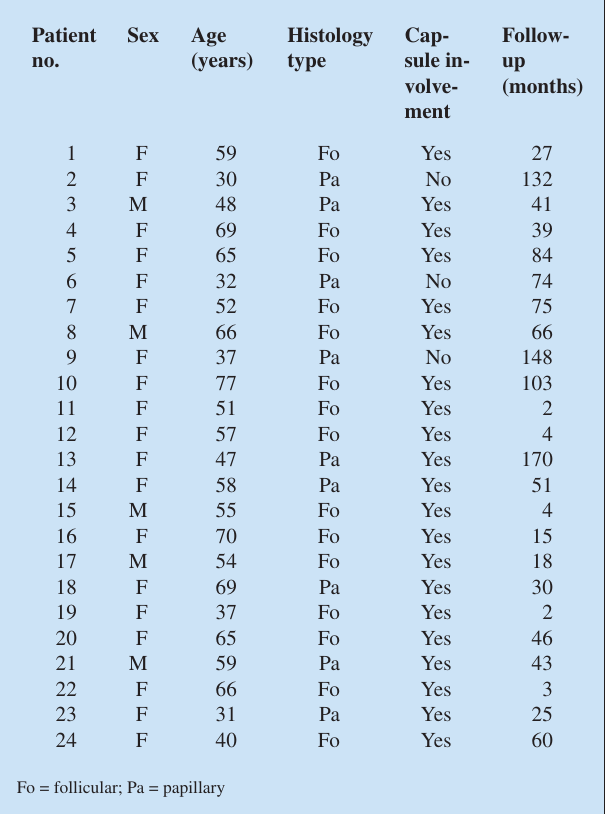
Table I. Clinical characteristics of the 24 patients with skeletal